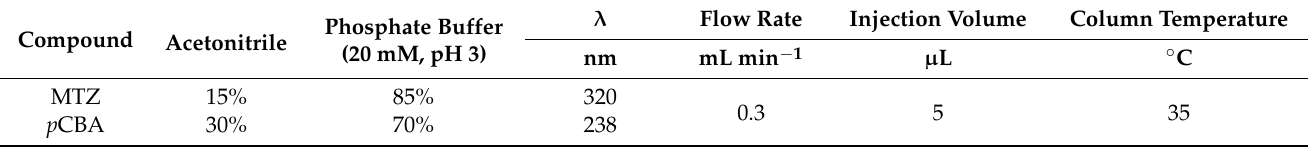
Table 1. UPLC method of MTZ and p